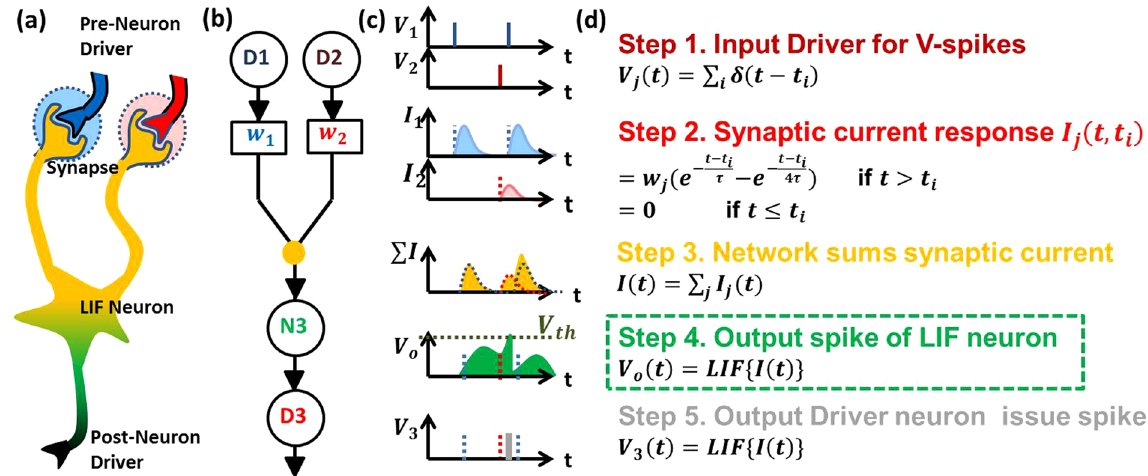
Figure 1. ( a ) Biological neuronal network is related to ( b ) algorithmic SNN analog. ( c ) The related signal timing ( d ) with step-wise signal evolution is shown. The SNN algorithm requires input spikes at times t i from j th pre-synaptic neuron driver e.g. D1, D2 (step 1). The spikes are converted into currents at synapse which depend upon synaptic strengths w j (step 2). The currents are summed by the networks (step 3) and input into LIF neuron that determines neuronal firing instants (step 4) while post-neuronal driver (D3) produces spikes at the firing instants.